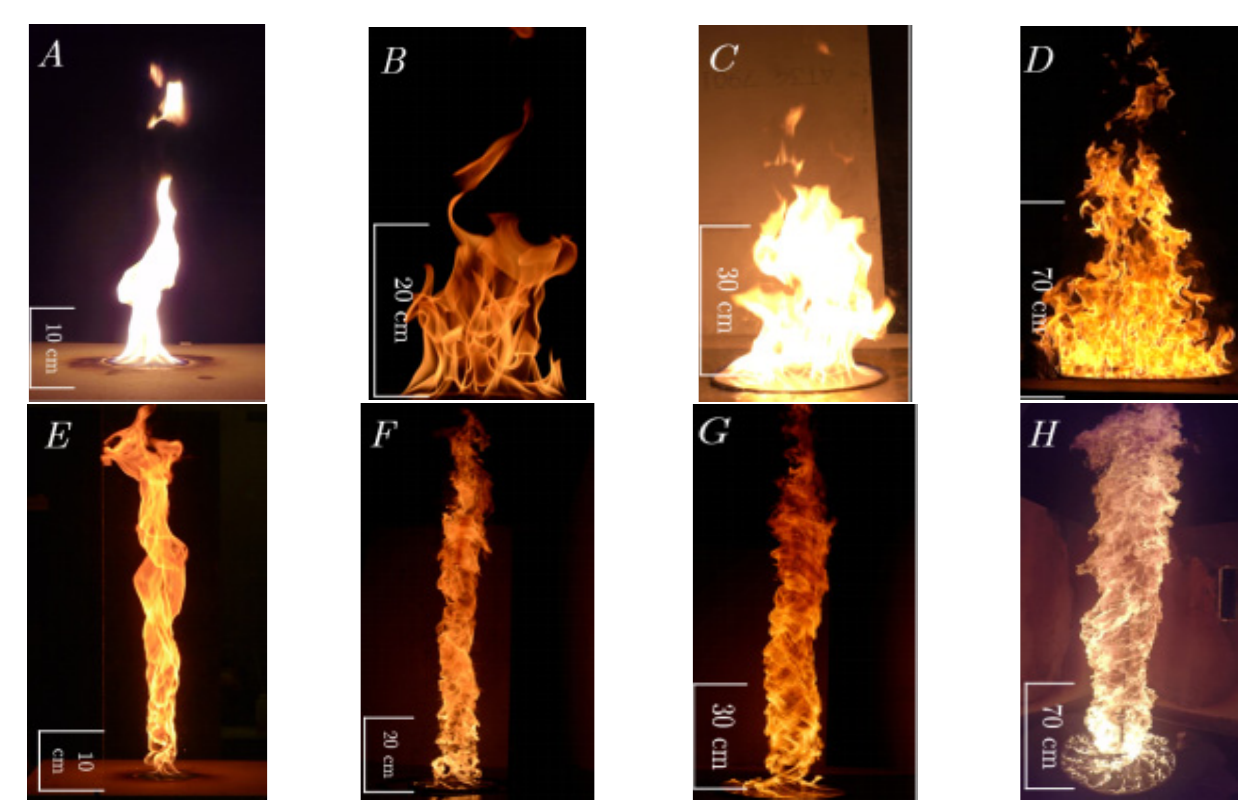
Figure 4. Instances of pool fire ( A – D ) and fire whirls (panels E – H ) constituted by heptane [29].